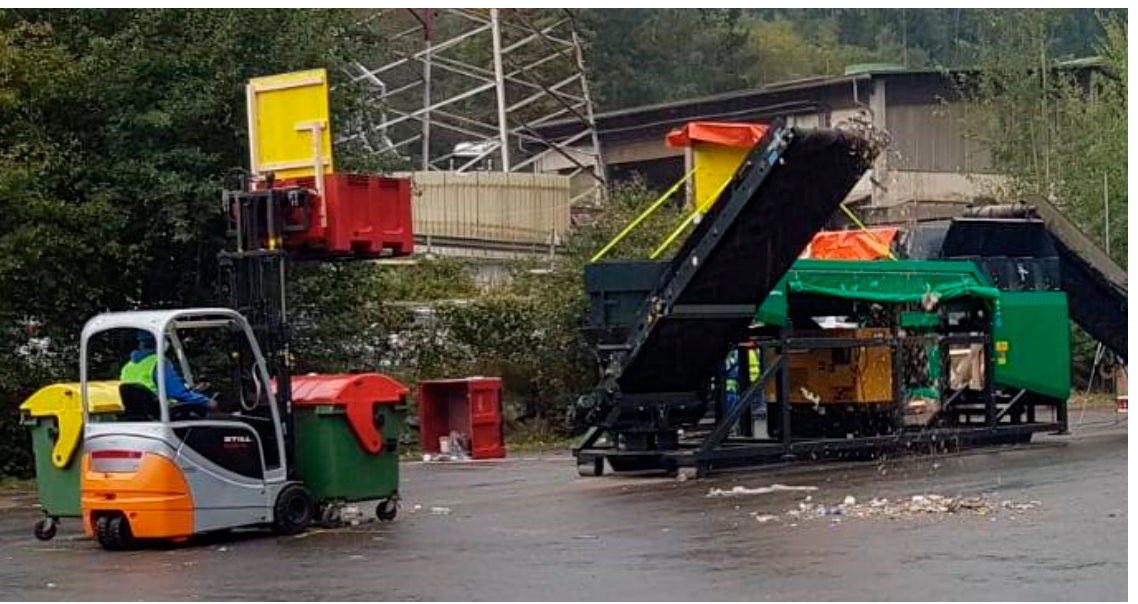
Figure 3. Sampling setup.